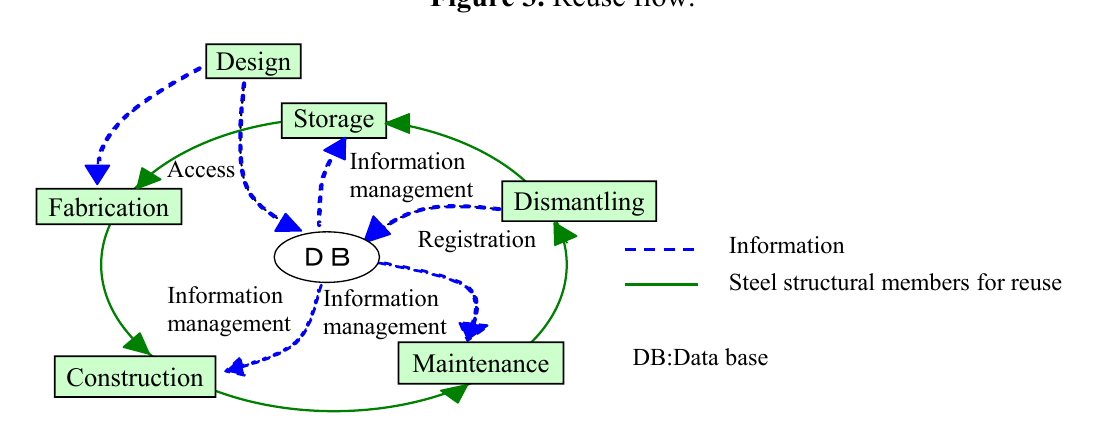
Figure 3. Reuse flow.